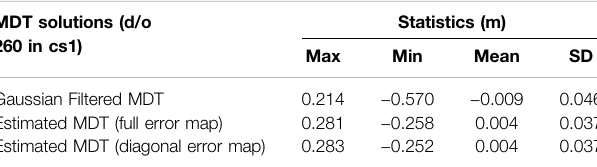
TABLE 4 | Statistics of mis fi ts between MDTs using GOCO06s against the Synthetic_MDT. MDT solutions (d/o 260 in